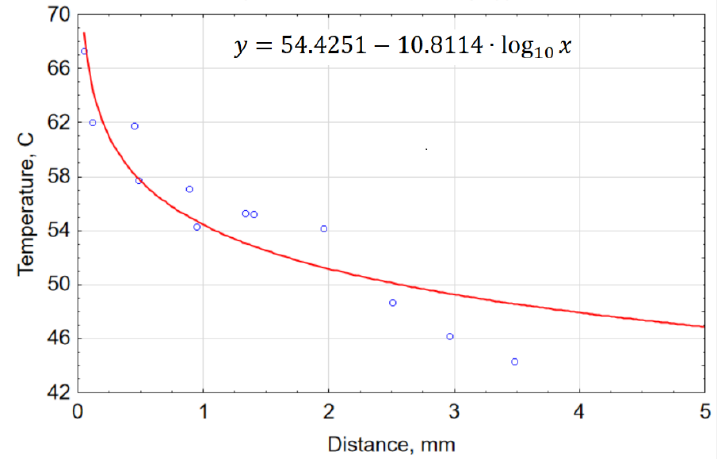
Figure 3. Temperature against distance from the edge in AWJM.